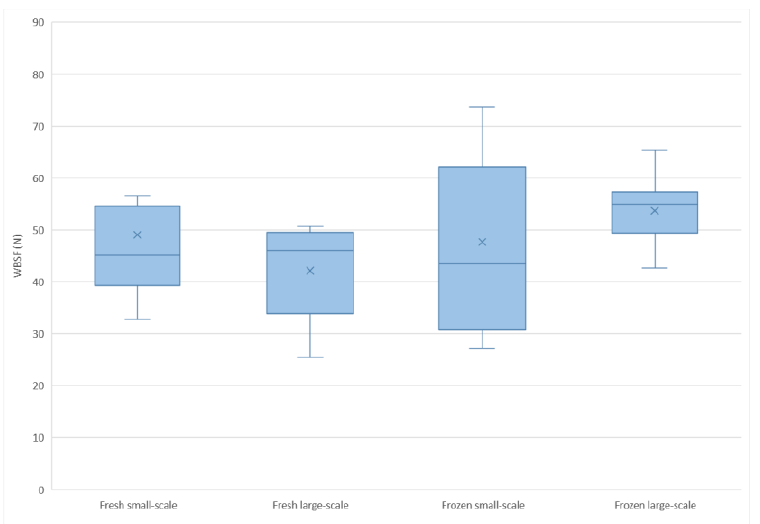
Figure 2. Boxplot showing Warner-Bratzler shear force (WBSF) in Newtons (N) for fresh and frozen meat samples from the small-scale and large-scale abattoirs.